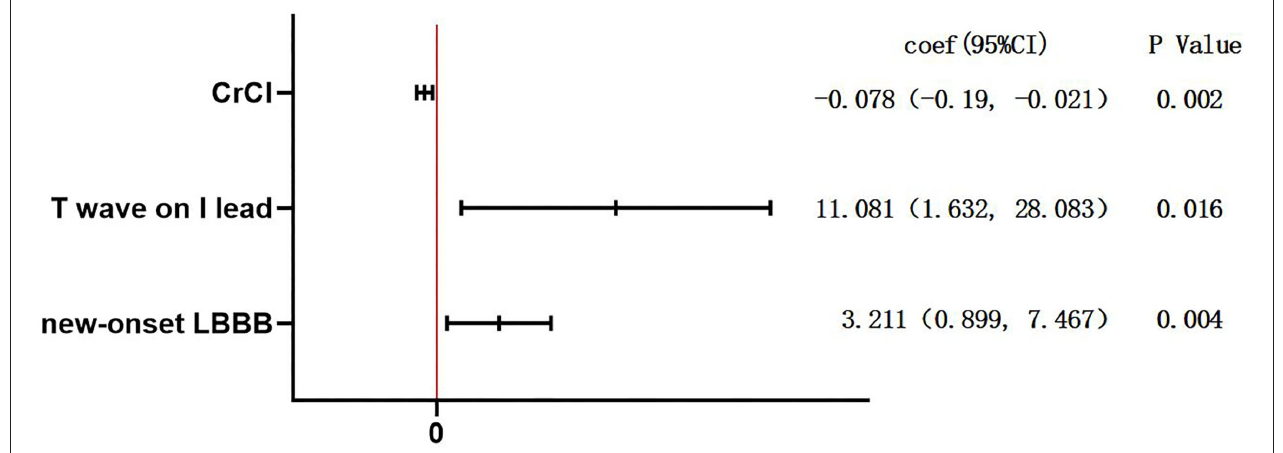
FIGURE 1 | Multiple logistic regression analysis for the predictors of permanent pacemaker (PPM) implantation. To identify predictors of patients with PPM dependency after transcatheter aortic valve replacement (TAVR), logistic regression, with Firth’s correction due to the small sample size, was performed. The variables to the right of the red line were predictors of PPM implantation. CrCl, creatinine clearance; LBBB, left bundle branch block.